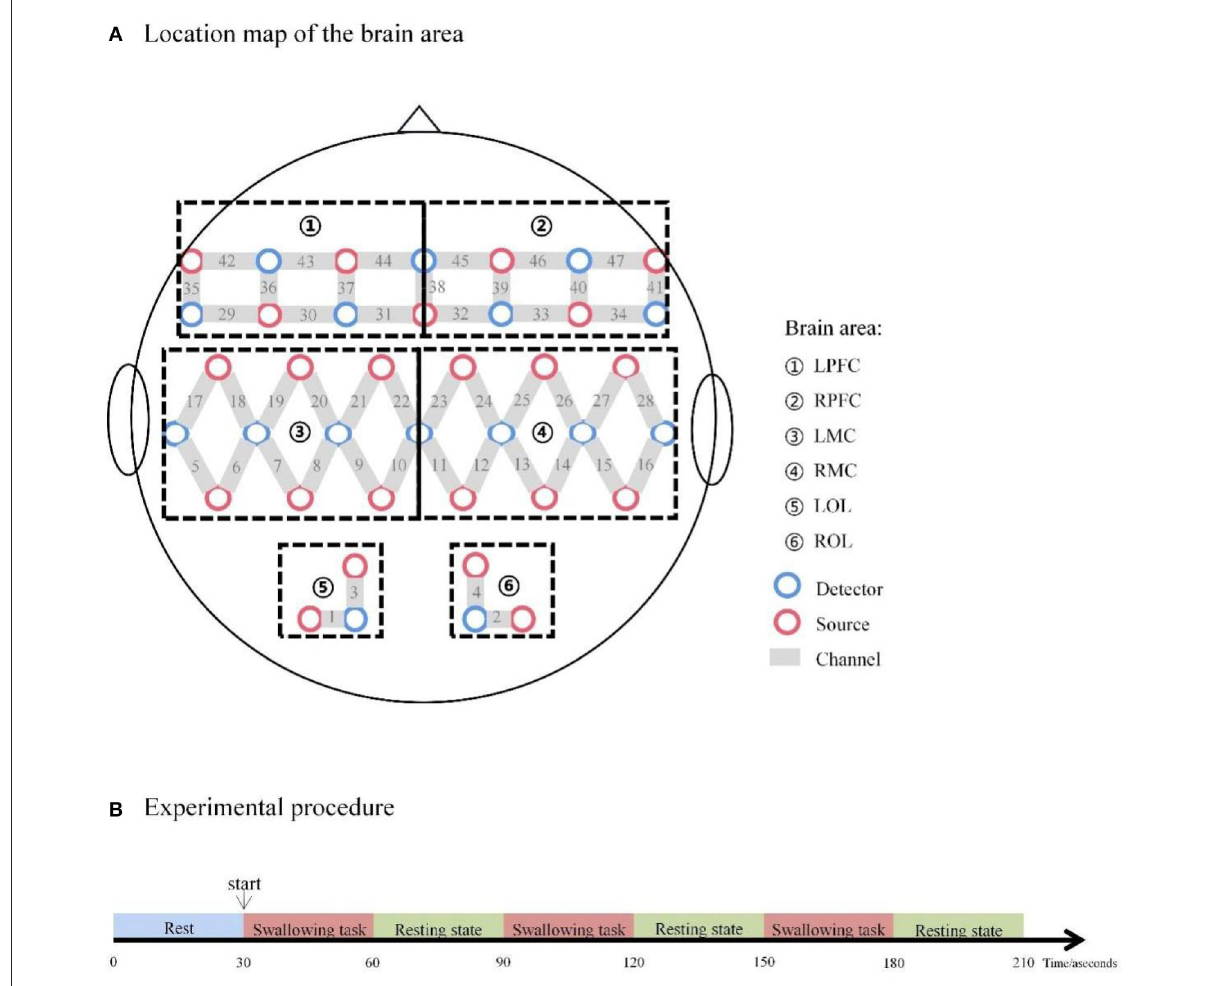
FIGURE1 (A) Location map of the brain area. (B) Experimental procedure. LPFC, left prefrontal cortex; RPFC, right prefrontal cortex; LMC, left motor cortex; RMC, right motor cortex; LOL, left occipital lobe; ROL, right occipital